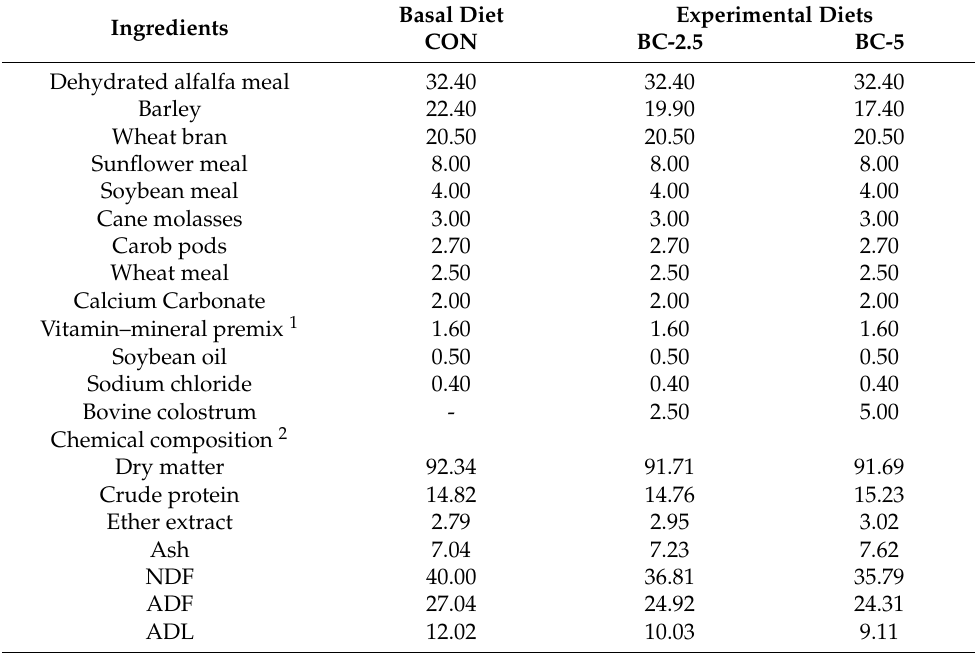
Table 1. Ingredients (percentage wet weight) of control (CON) and experimental diets of post- weaning